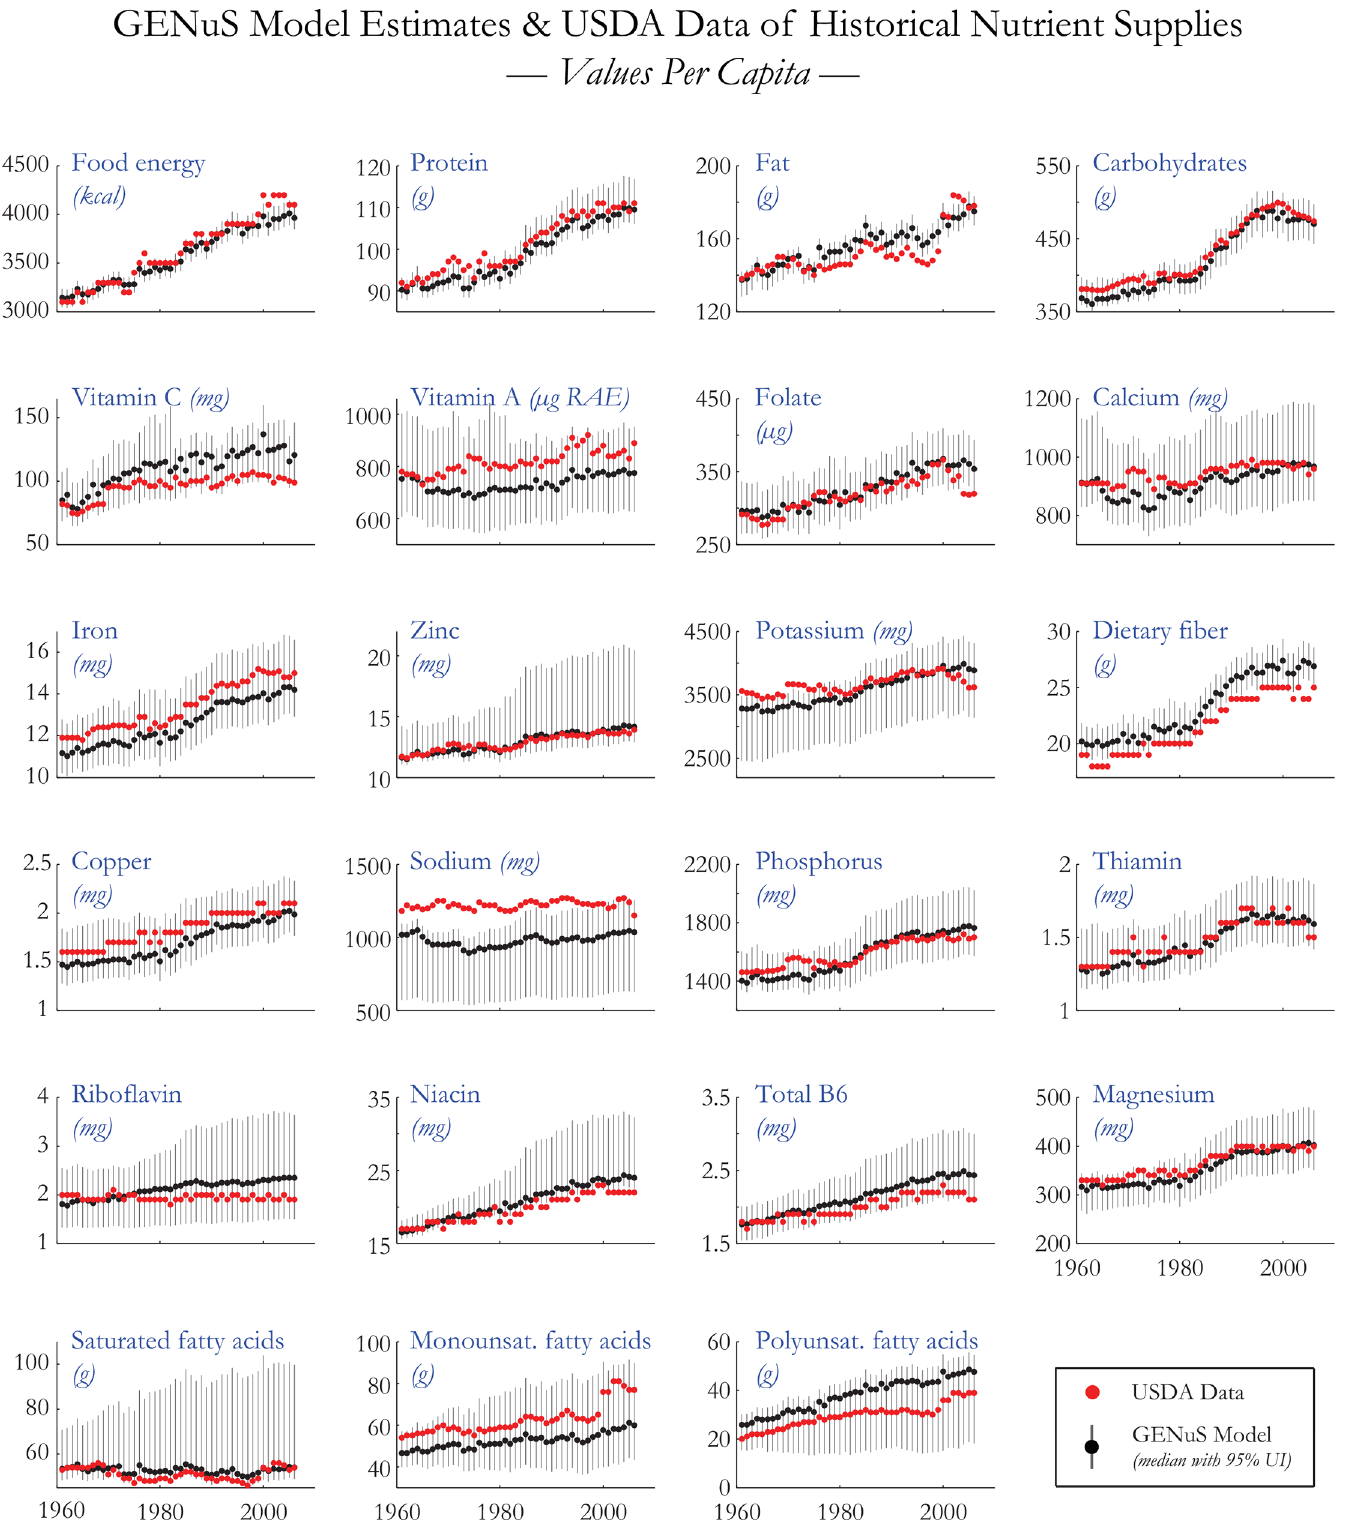
Fig 2. GENuS-USDA Nutrient Supply Comparison. Comparisons of GENuS model estimates and USDA nutrient supplies (data available in S1 Data). To compare GENuS estimates with historical data (where fortification levels are not estimated), the USDA supplies shown exclude nutrients added through fortification. A comparison of the USDA values and the GENuS model including fortification is found in Table 3.